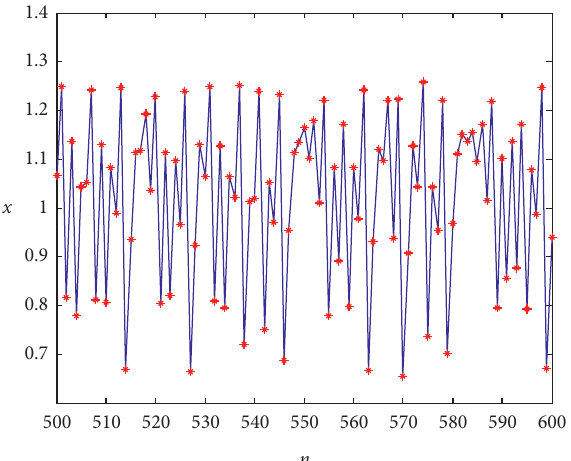
Figure 8: x - y phase diagram which denotes that the system is periodic when α � 0.95.